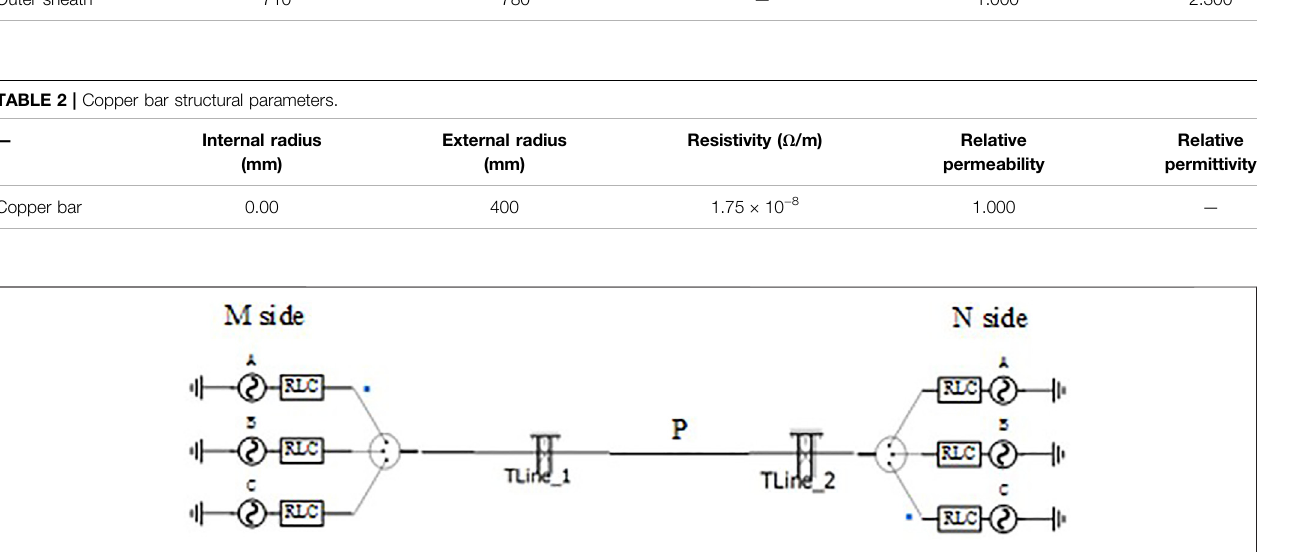
FIGURE 6 | Schematic diagram of the overhead line simulation